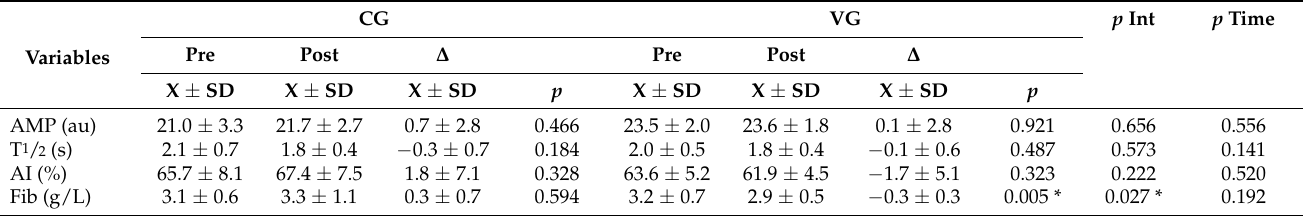
Table 4. Values of indexes of erythrocytes aggregation and fibrinogen concentration and their differences ( ∆ ) in the control (CG) and examined (VG) groups before and after three vibrotherapy series, considering interactions between the groups ( p int) and changes over time ( p time).